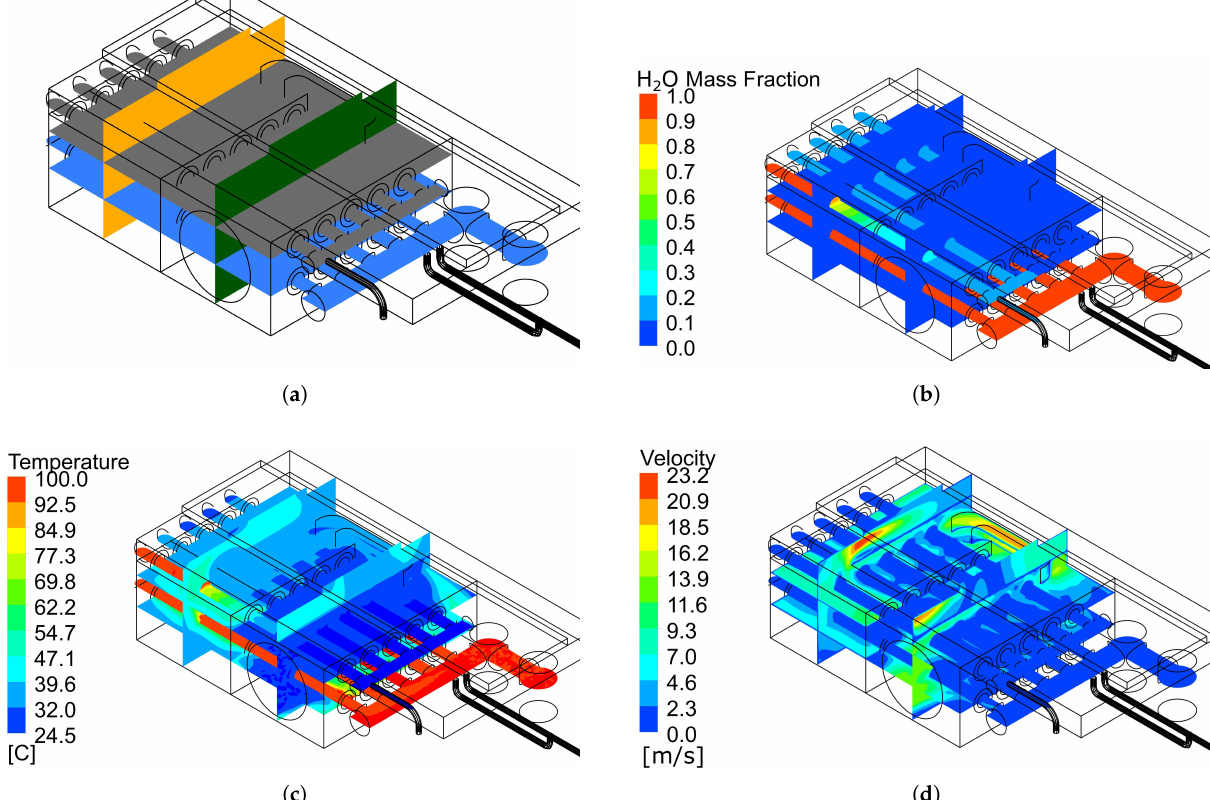
Figure 6. ( a ) Cross-sections; ( b ) H 2 O mass fraction; ( c ) temperature distribution; ( d ) velocity